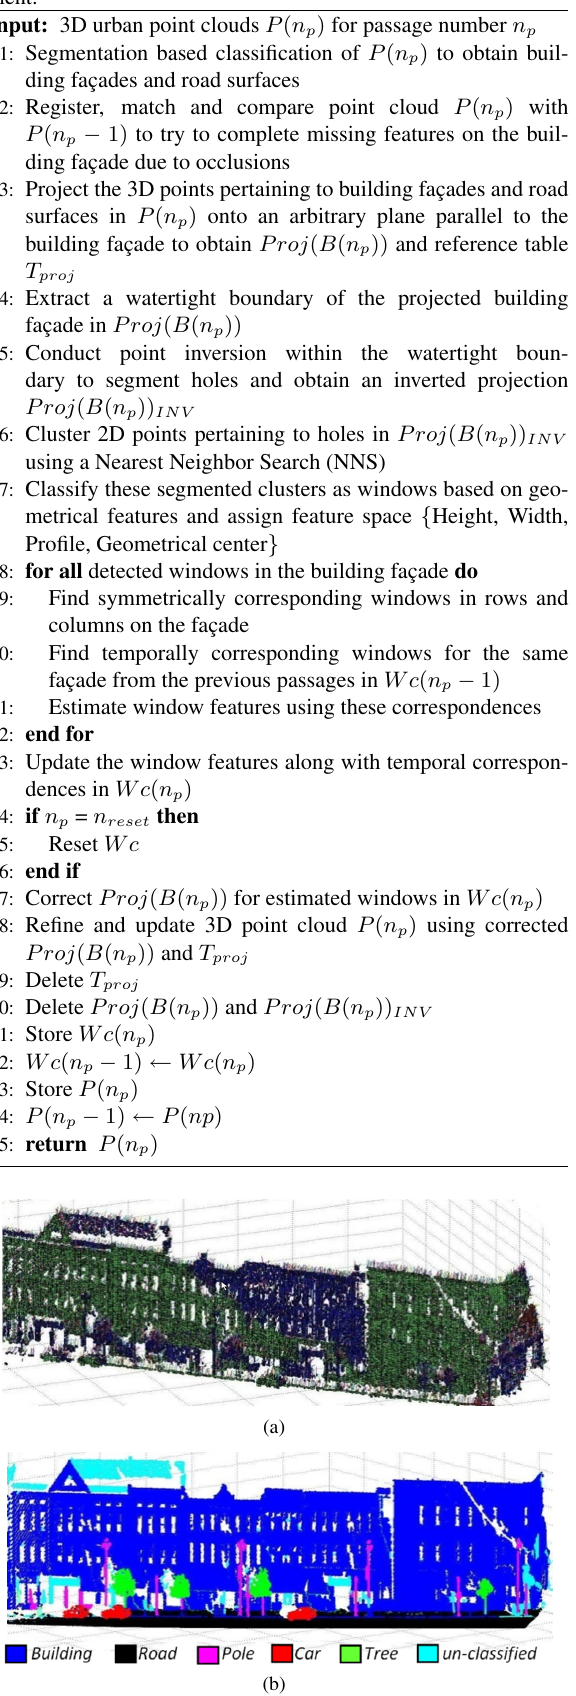
Algorithm 1 Automatic window detection and fac¸ade refine- ment.